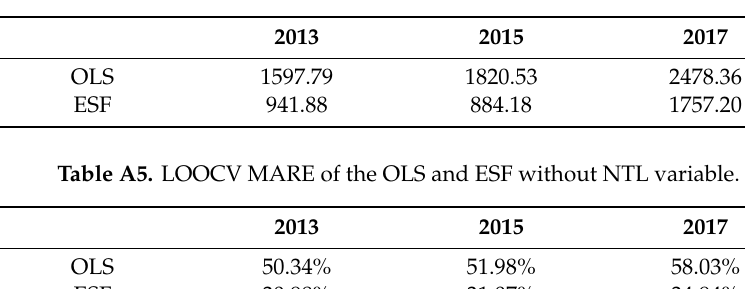
Table A4. LOOCV RMSE of the OLS and ESF without NTL variable.